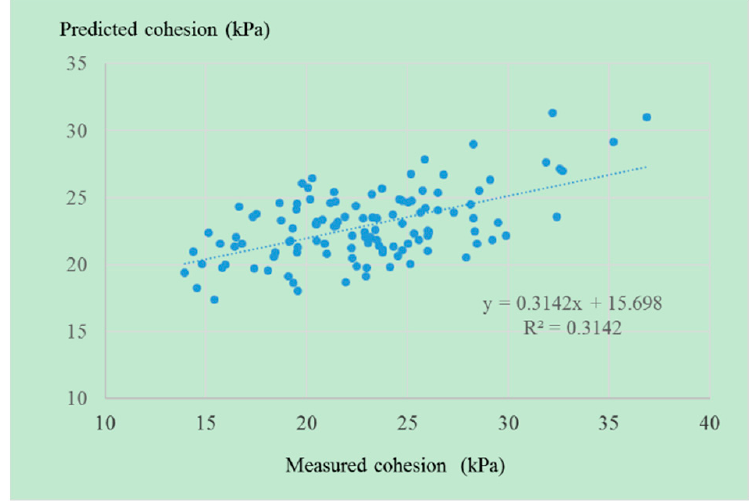
Figure 6. Results of cohesion hyperspectral detection model. Table 2. t -test on the regression coefficients of the